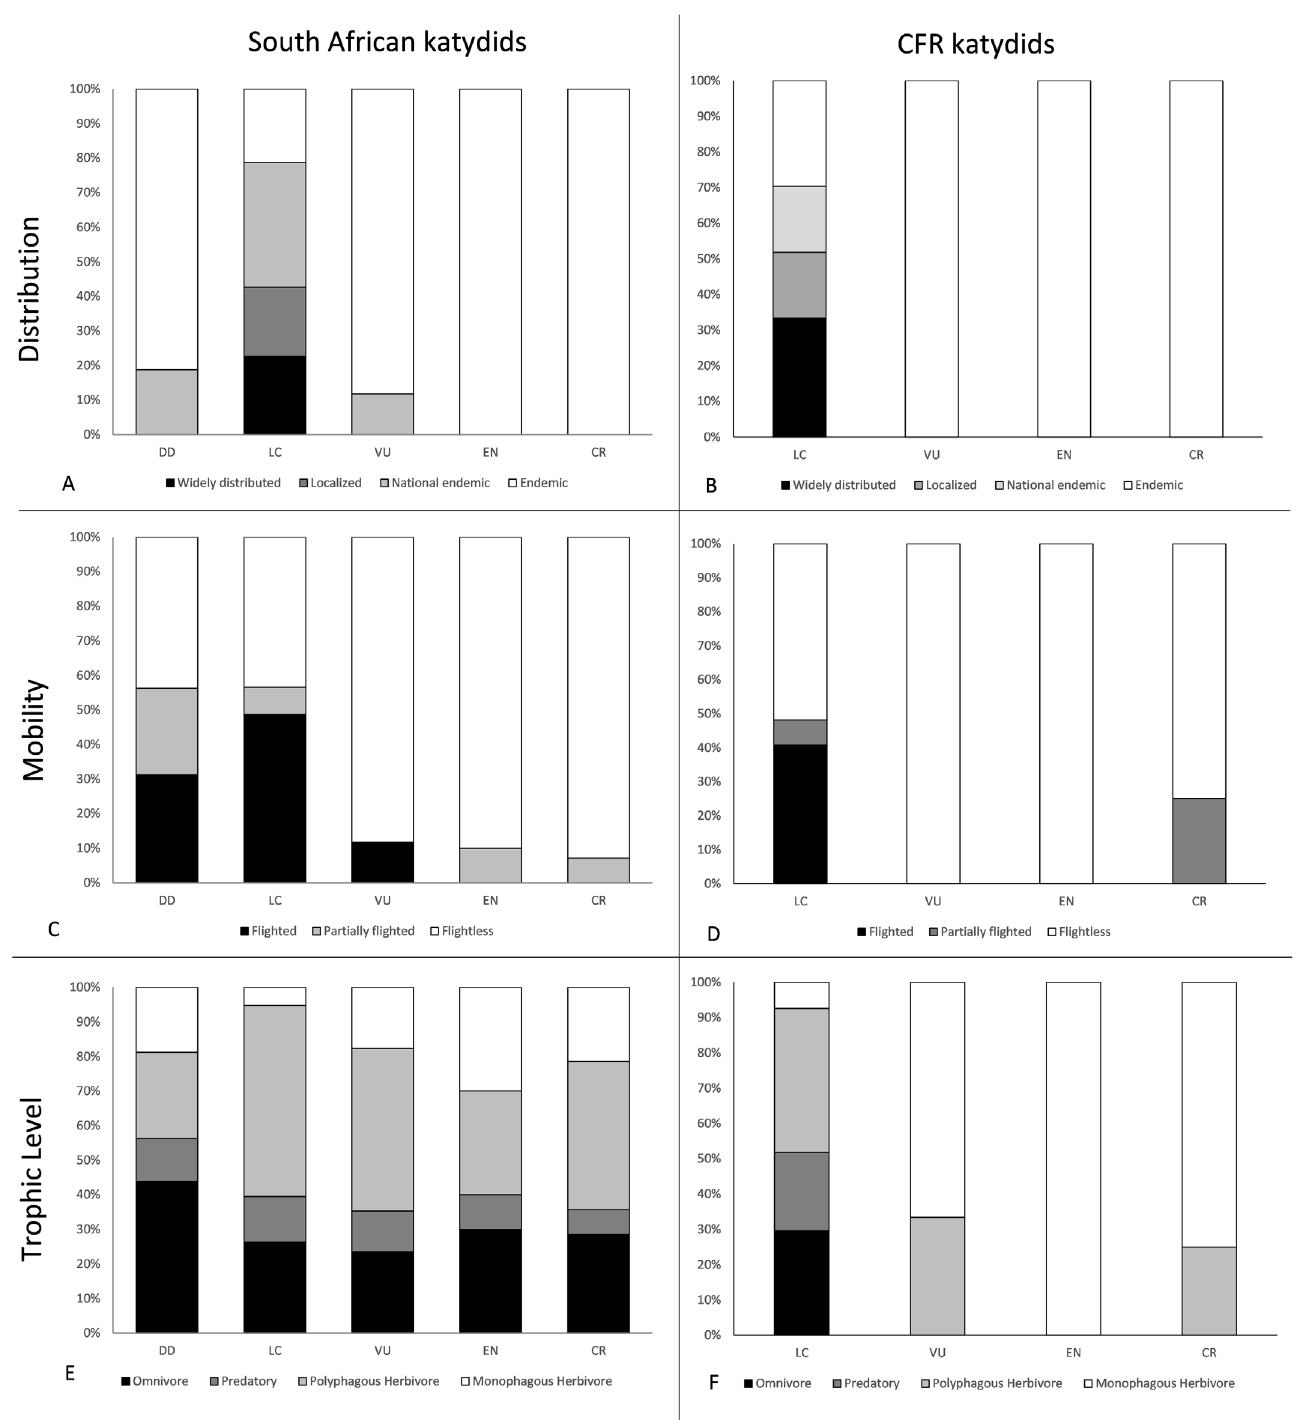
Figure 2. Composition of South African ( A, C, E ) and Cape Floristic Region ( B, D, F ) katydid assemblages as characterised by their distribution ( A, B ), mobility ( C, D ), and trophic level ( E, F ) relative to their IUCN threat status.